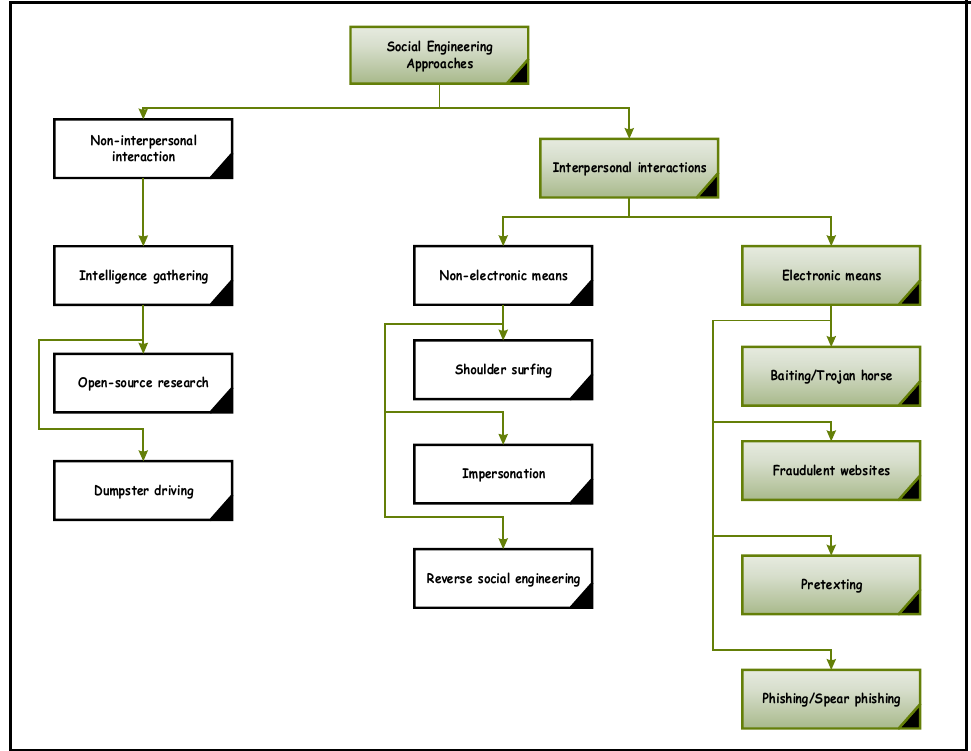
Figure 1. Social engineering attack taxonomy.